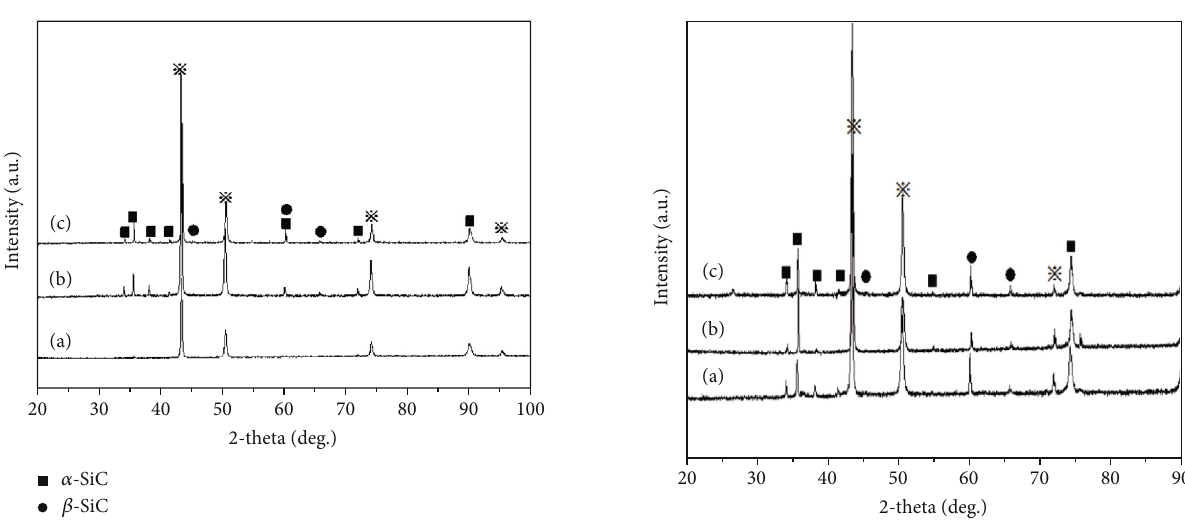
Figure 4: XRD curve of SiC@Cu/Cu composites. (a), (b), and (c) presented the SiC@Cu volume fraction with 10%, 30%, and 50%.